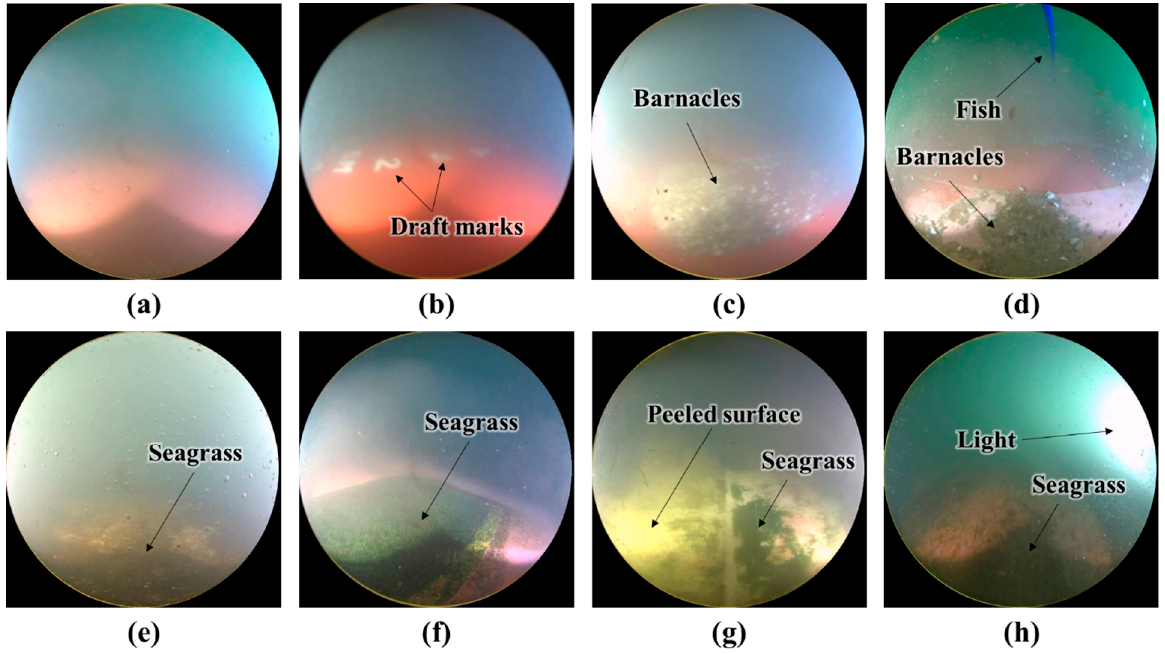
Figure 4. Example images: ( a , b ) clean and ( c – h ) unclean